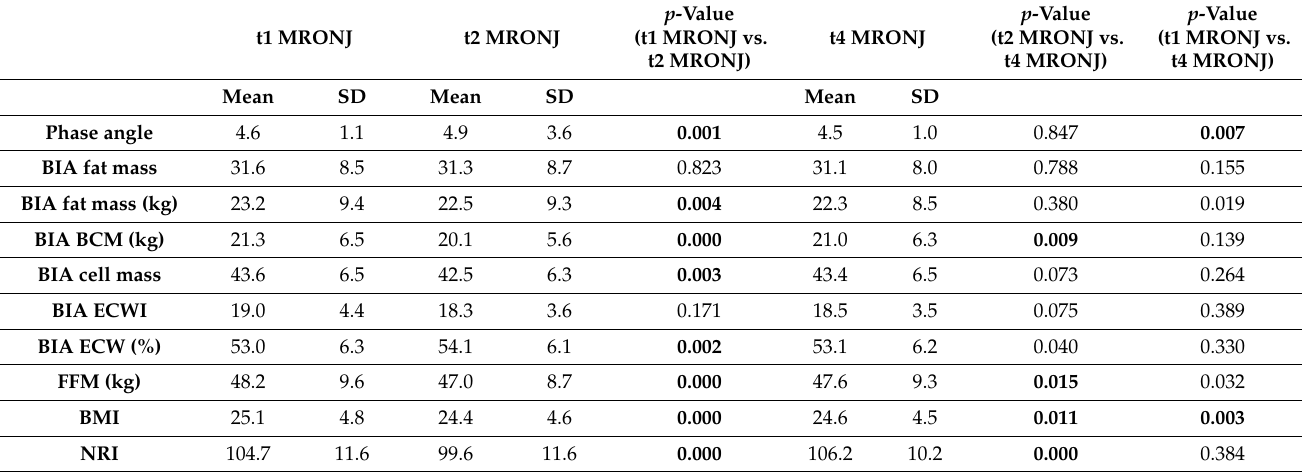
Table 7. Anthropometric measurements at different points in time (t1, t2, t4). p -values < 0.017 are statistically significant. t1